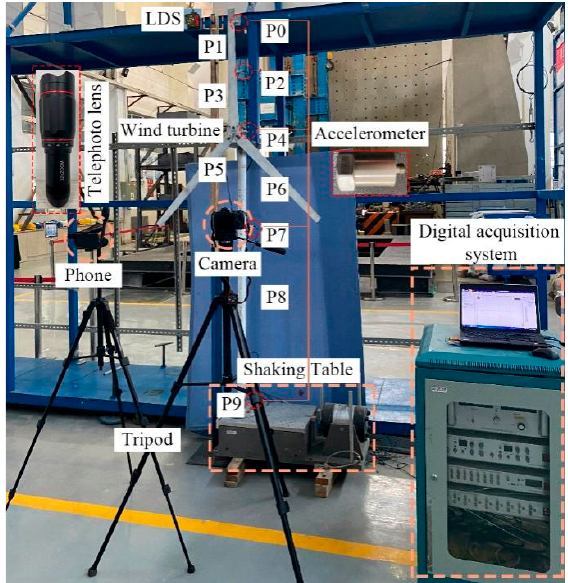
Figure 20. Experimental equipment.